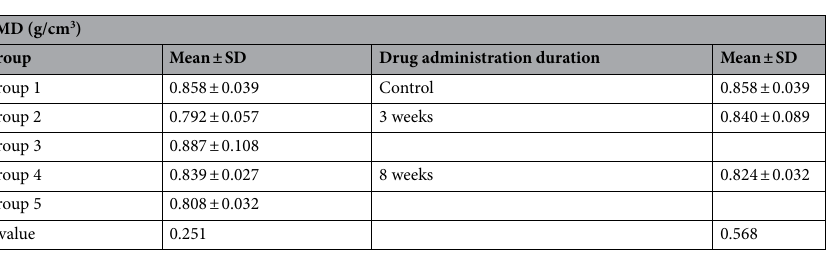
Table 3. Bone mineral density (BMD) in oral administration model groups showing the effect of bisphosphonate on the bone in groups with a medication discontinuation compared with the control group. The statistical analysis was performed using ANOVA. The data are depicted as the mean ± standard deviation. BMD bone mineral